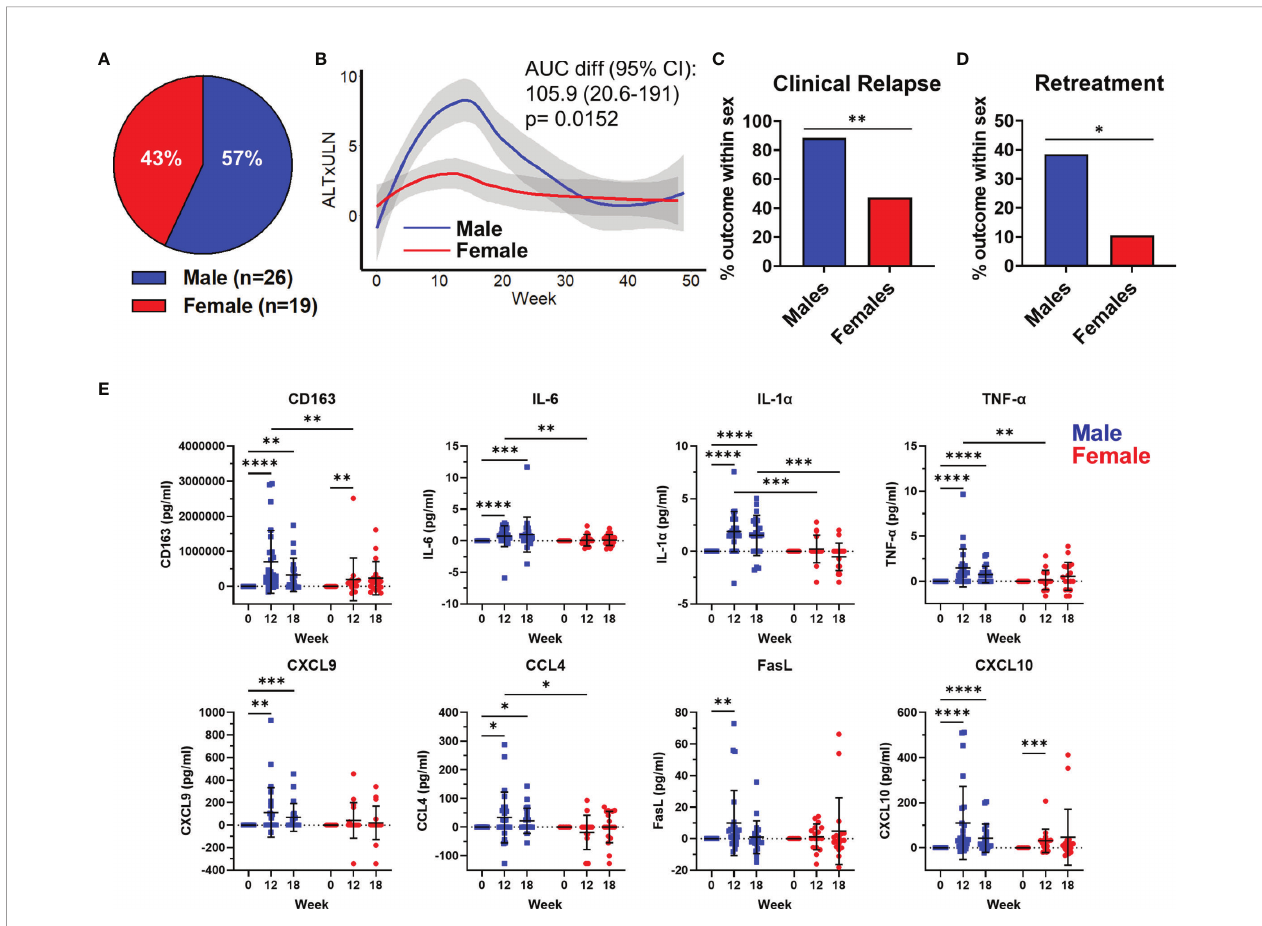
FIGURE 1 | HBV reactivation following treatment cessation induces a myeloid in fl ammatory pro fi le in the plasma of chronic hepatitis B patients. A description of the cohort has been previously published (13). (A) Distribution of participants sex (n=26 males, 19 female) in the Toronto STOP study. (B) Loess regression curves of male and female ALT levels as a multiple of upper limit of normal (ALTxULN) during the 48 week follow up to stopping Nuc therapy. (C) Incidence of clinical relapse in males and females. (D) Proportion of male and female patients who required retreatment after stopping Nuc therapy. (E) Plasma levels of cytokines and chemokines at 12w and 18w after stopping Nuc therapy relative to baseline values at week 0. *p<0.05, **p<0.01, ***p<0.001, ****p<0.0001, Mann-Whitney U tests. Figures depict mean +/-